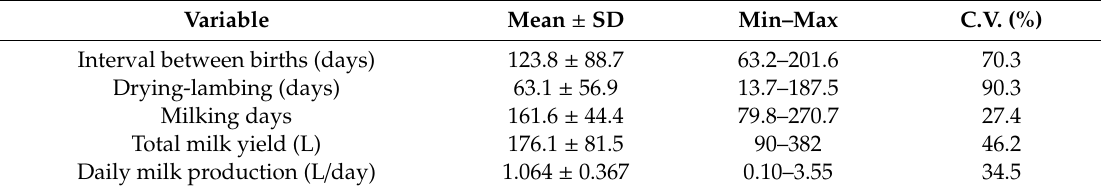
Table 2. Global descriptive statistics of the di ff erent degrees of crossbreeding of Lacaune x Manchega dairy sheep in a commercial flock, in